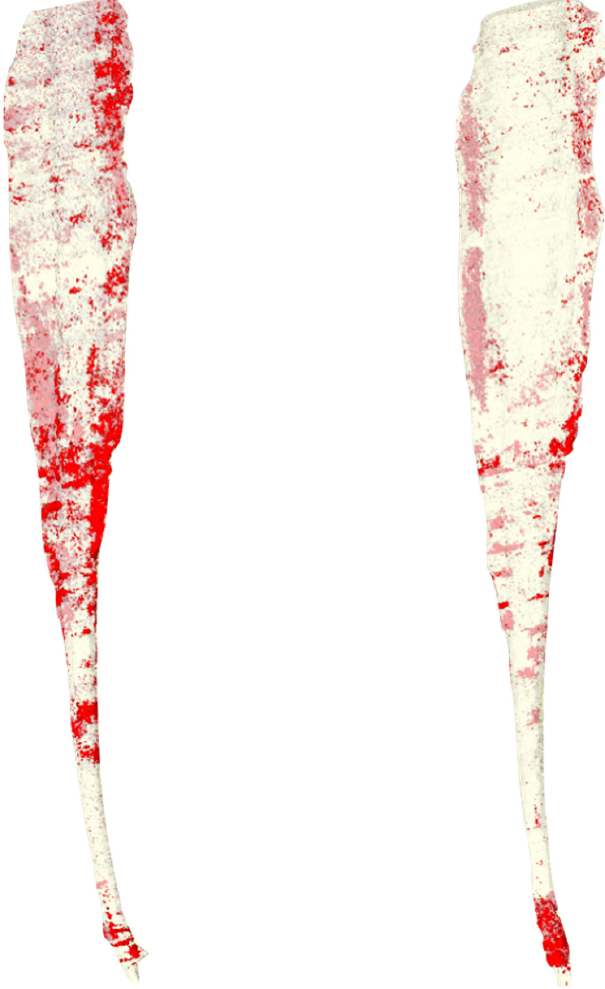
Figure 4. EA group—3D evaluation of ATHD before (image left) and after (image right) irrigant activation. Table 1. EA group—volume (mm 3 ) of AHTD before and after the irrigant activation.